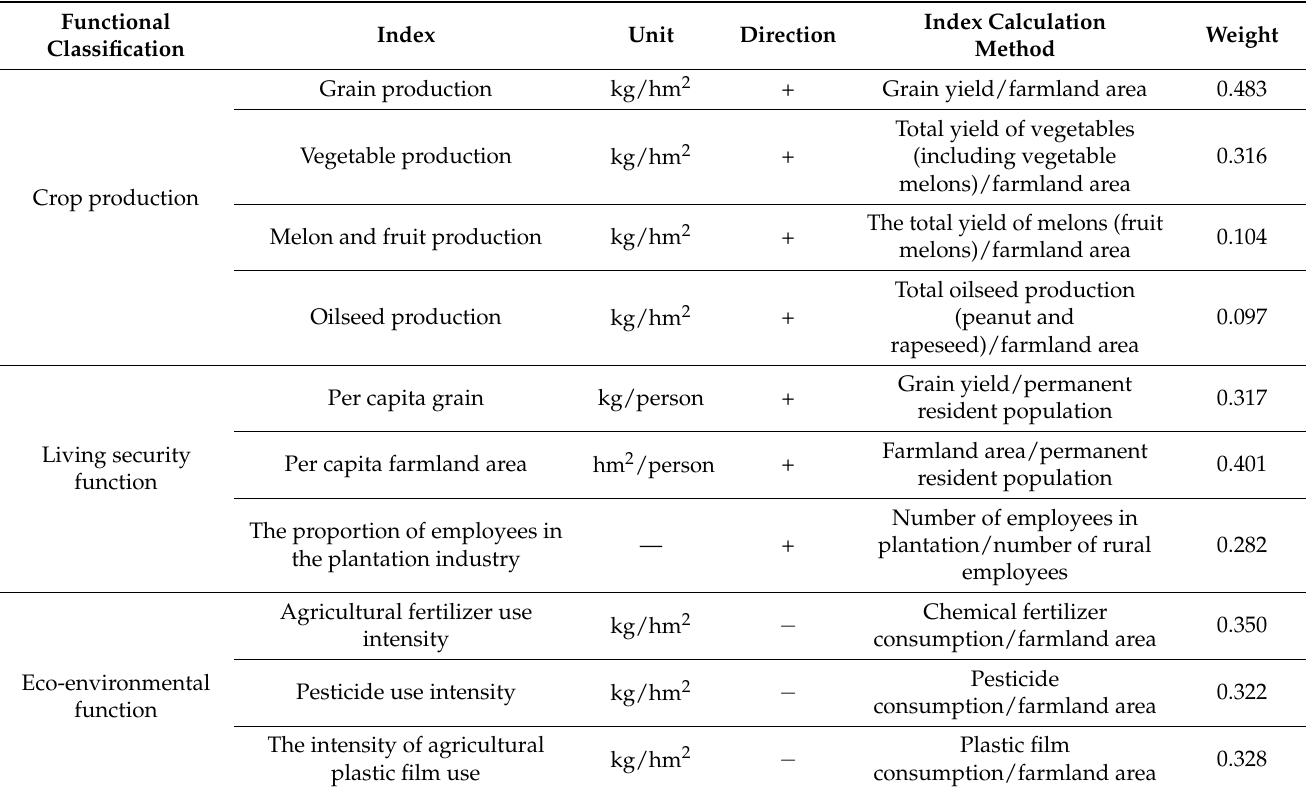
Table 2. The evaluation indexes of farmland